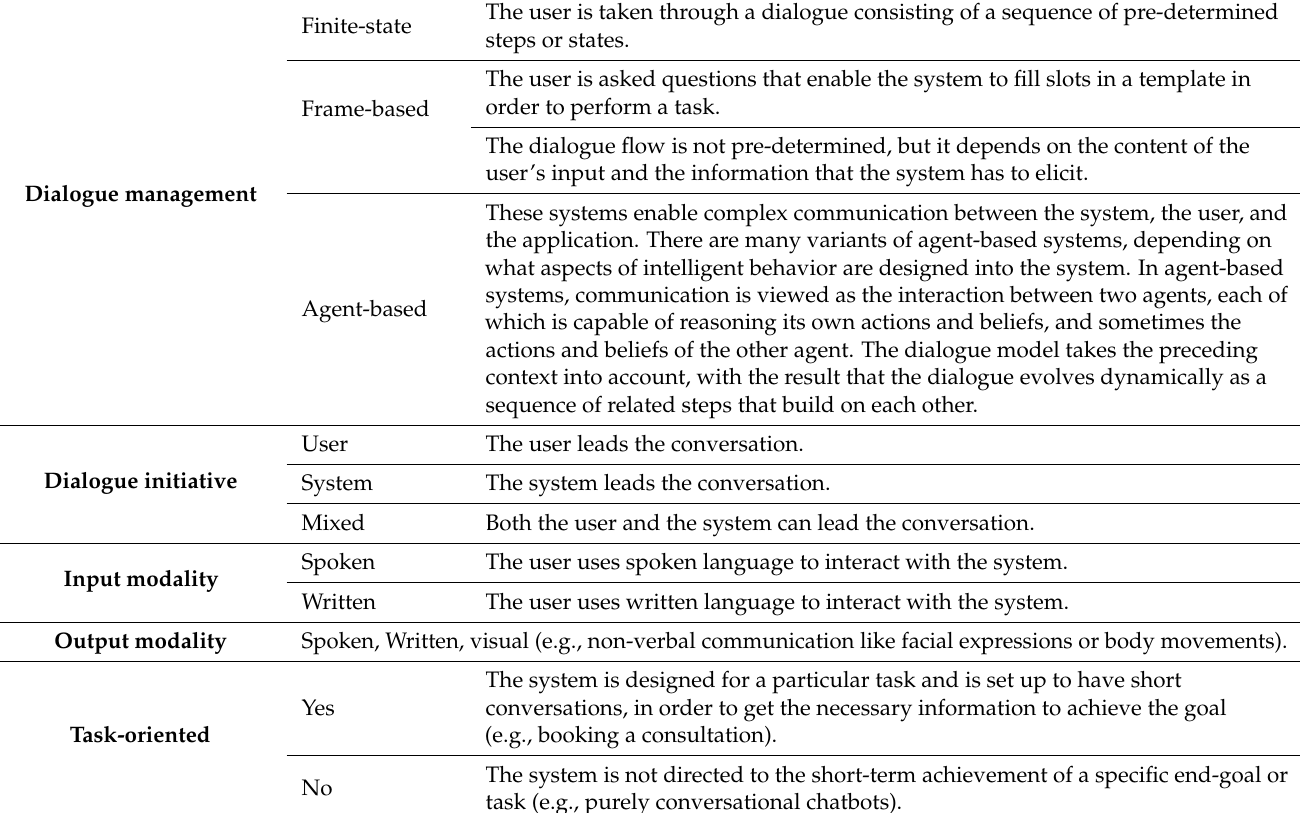
Table 3. Characterisation of conversational agents (Laranjo et al. 2018